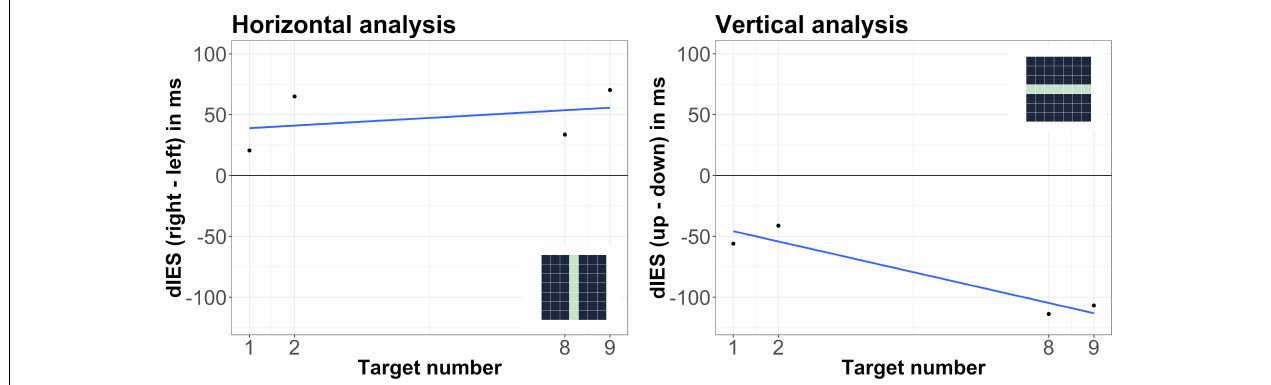
FIGURE 3 | Differences between IES (dIES) when target numbers were presented at different locations on the screen. Left: left vs. right presentation, positive values indicate more efficient responses for left presentation; right: lower vs. upper presentation, negative values indicate more efficient responses for upper presentation. The spatial positions within the 7 × 7 grid that were compared against each other in the respective analysis are illustrated as dark areas in the depicted miniature 7 × 7 grids.